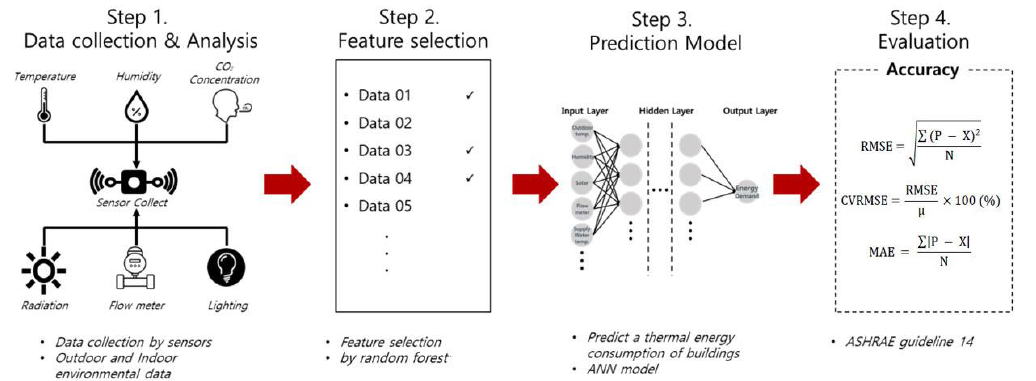
Figure 3. Process steps for constructing the machine learning model.